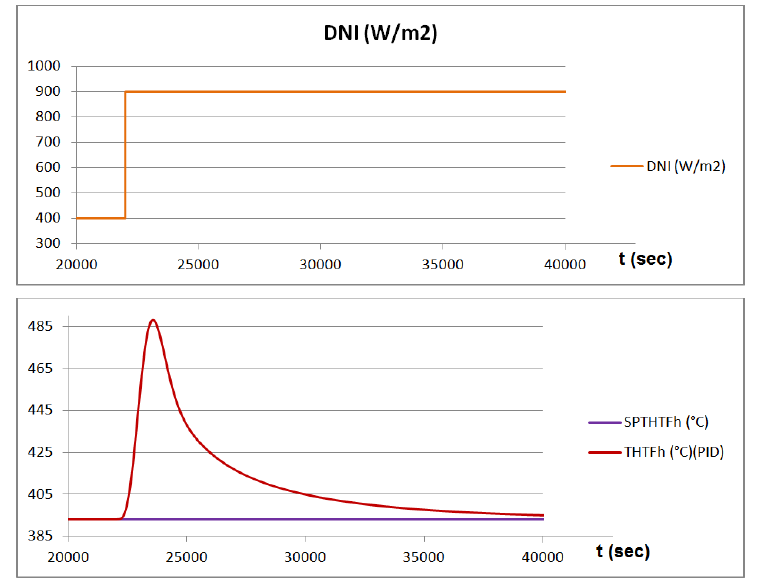
Figure 18. PID controller response to a sharp step in direct solar irradiation (DNI).